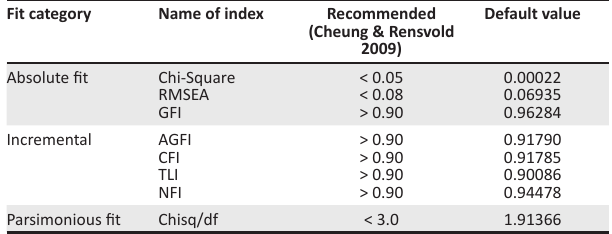
TABLE 7 : Fit indices for structural model. TABLE 5 : Test for unidimensionality.